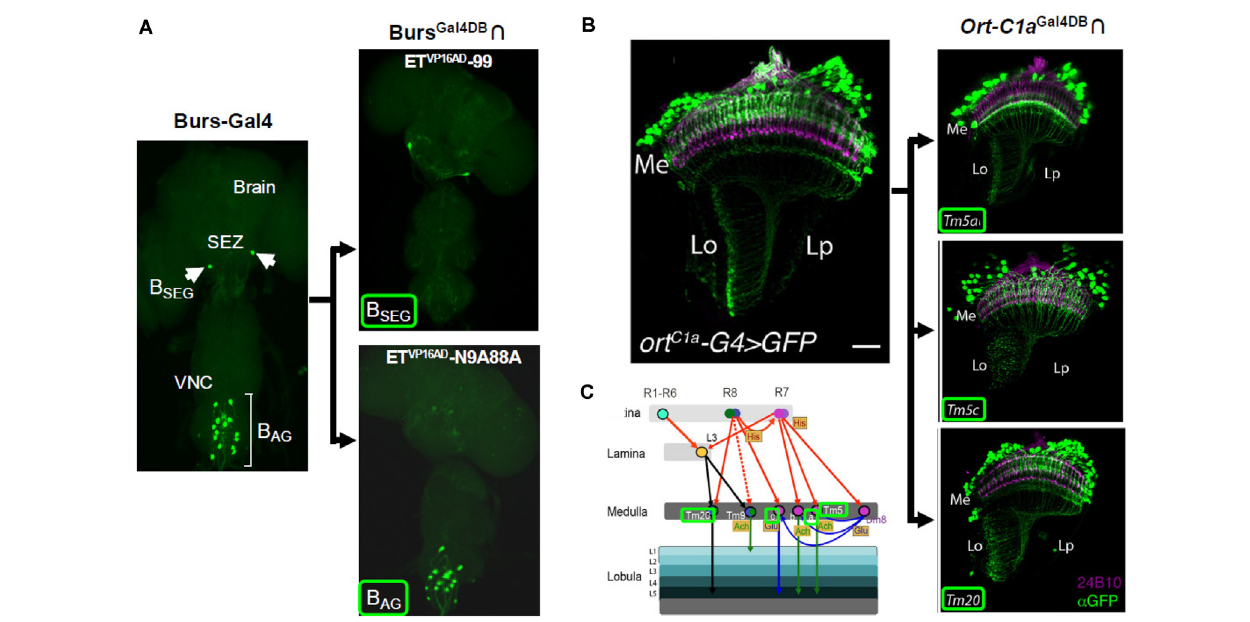
FIGURE 2 | Cell type-specific expression achieved with Split Gal4. (A) The B AG and B SEG are groups of neurons in the ventral nerve cord (VNC) and subesophageal zone (SEZ), respectively, that express the hormone, Bursicon (left). A Burs Gal4DBD hemidriver in combination with two distinct enhancer-trap Zip + -VP16AD hemidrivers can be used to individually target each group (right panels). (B,C) Split Gal4 parsing of medulla neurons. (B) Medulla neurons that receive input from photoreceptors are labeled by the ort-C1a -Gal4 driver (ort C1a -G4, left). Three subpopulations of these neurons, Tm5a, Tm5c, and Tm20, with different projection patterns, are identified by an ort-C1a Gal4DBD hemidriver used with different enhancer-trap Zip + -dVP16AD hemidrivers (right panels). (C) Schematic showing input and output patterns of Tm5a, Tm5c, and Tm20 neurons (names outlined in green). Panel (A) adapted from Luan et al. (2012); panels (B,C) from Melnattur et al. (2014).